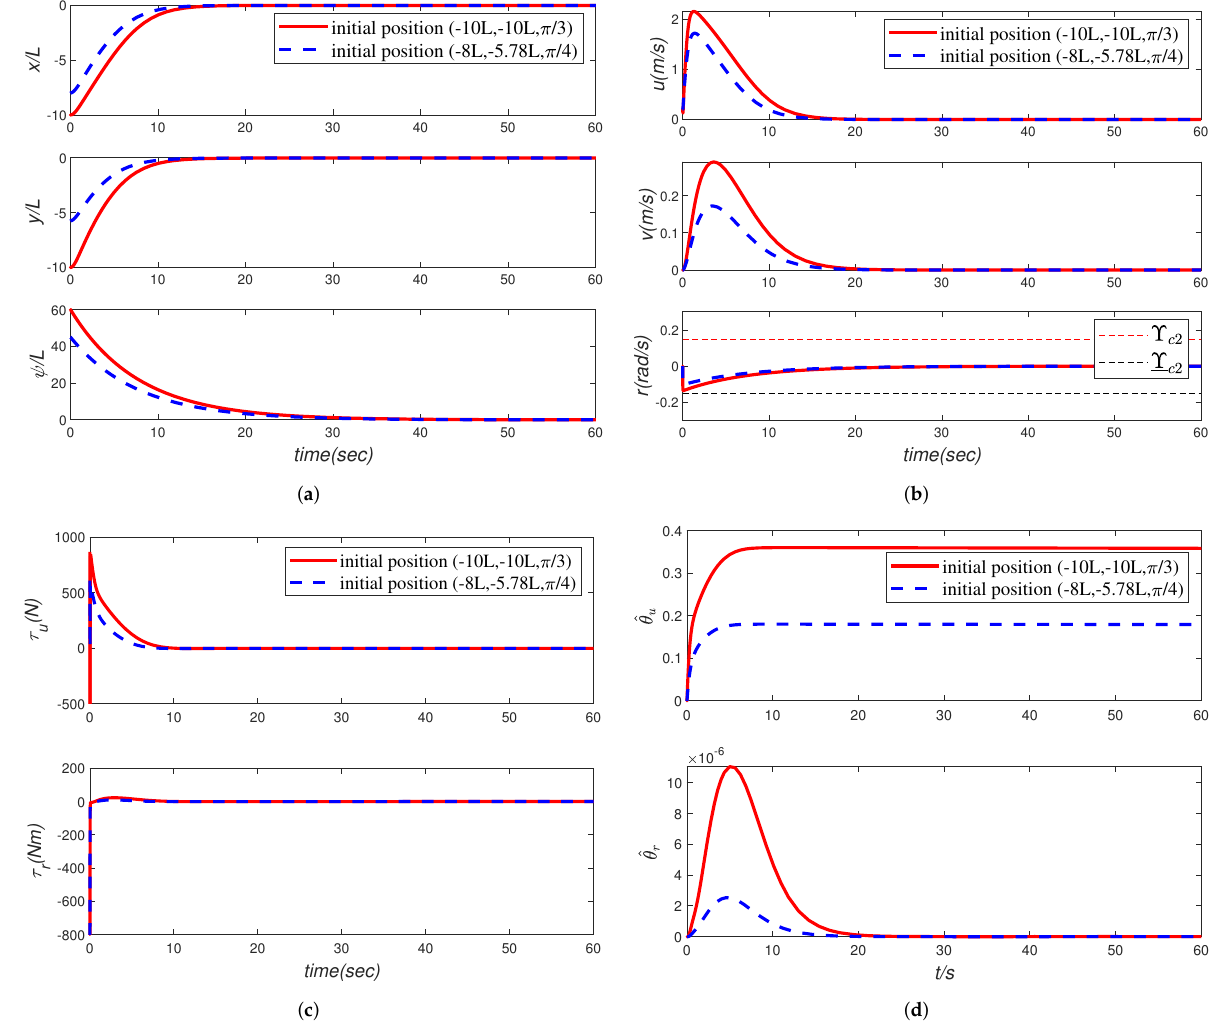
Figure 7. Comparisons of control scheme Equation (49) with different initial position. ( a ) Comparisons of x , y , and ψ . ( b ) Comparisons of u , v , and r . ( c ) Comparisons of τ u and τ r . ( d ) Comparisons of ˆ δ u and ˆ δ r .